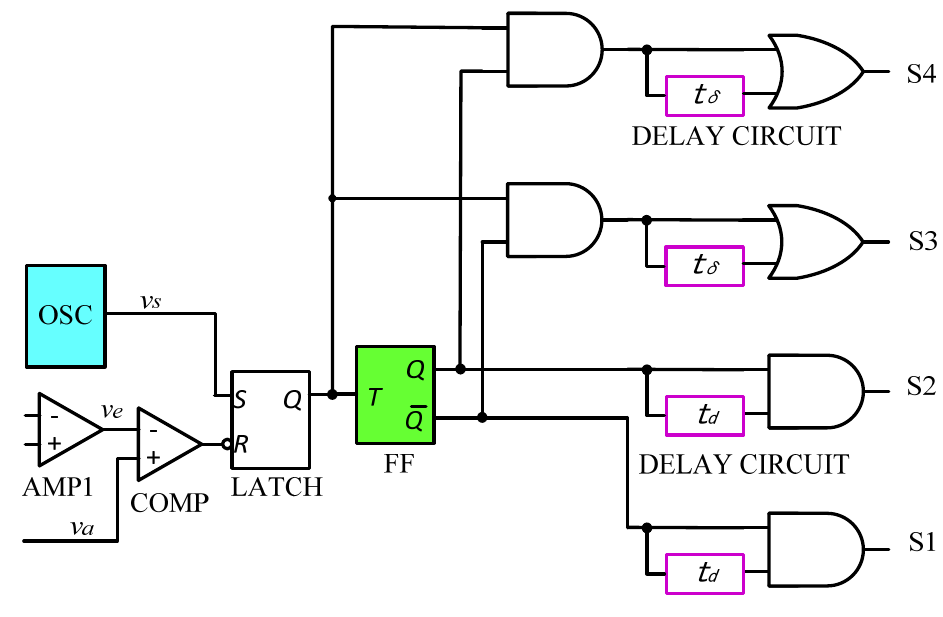
Figure 7. Timing diagram of the controller.